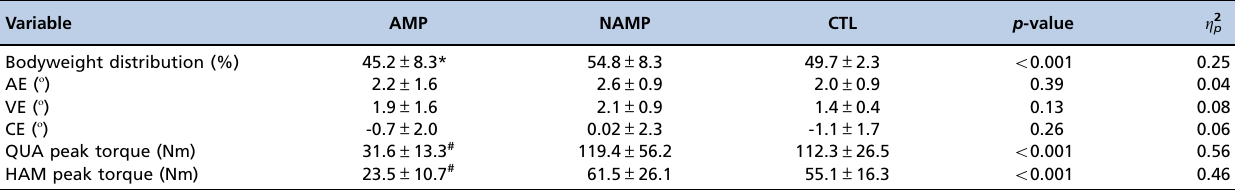
AMP, amputated limb. NAMP, non-amputated limb. CTL, control limb (control group dominant leg). AE, absolute error. VE, variable error. CE, constant error. QUA, quadriceps. HAM, hamstrings. *Significantly different from NAMP. # Significantly different from the NAMP and CTL groups. The p -values were